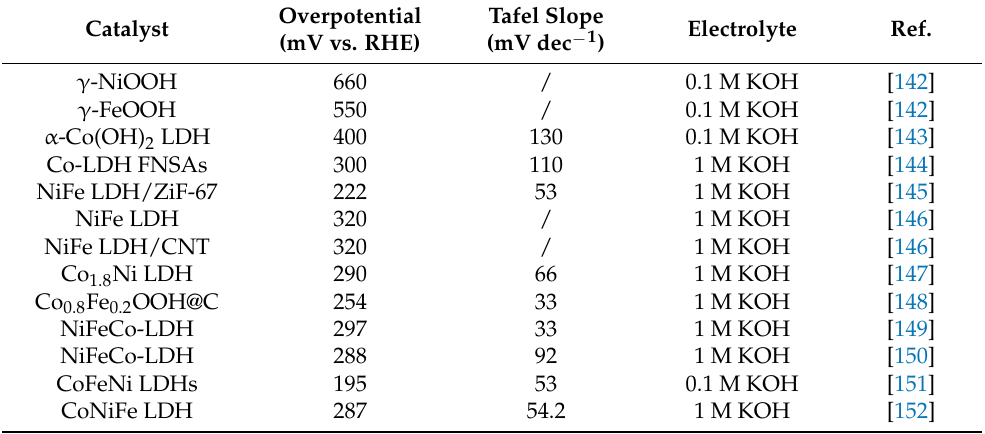
Table 3. Comparison of OER activities of recent TM-LDHs in alkaline media at a current density of 10 mA cm − 2